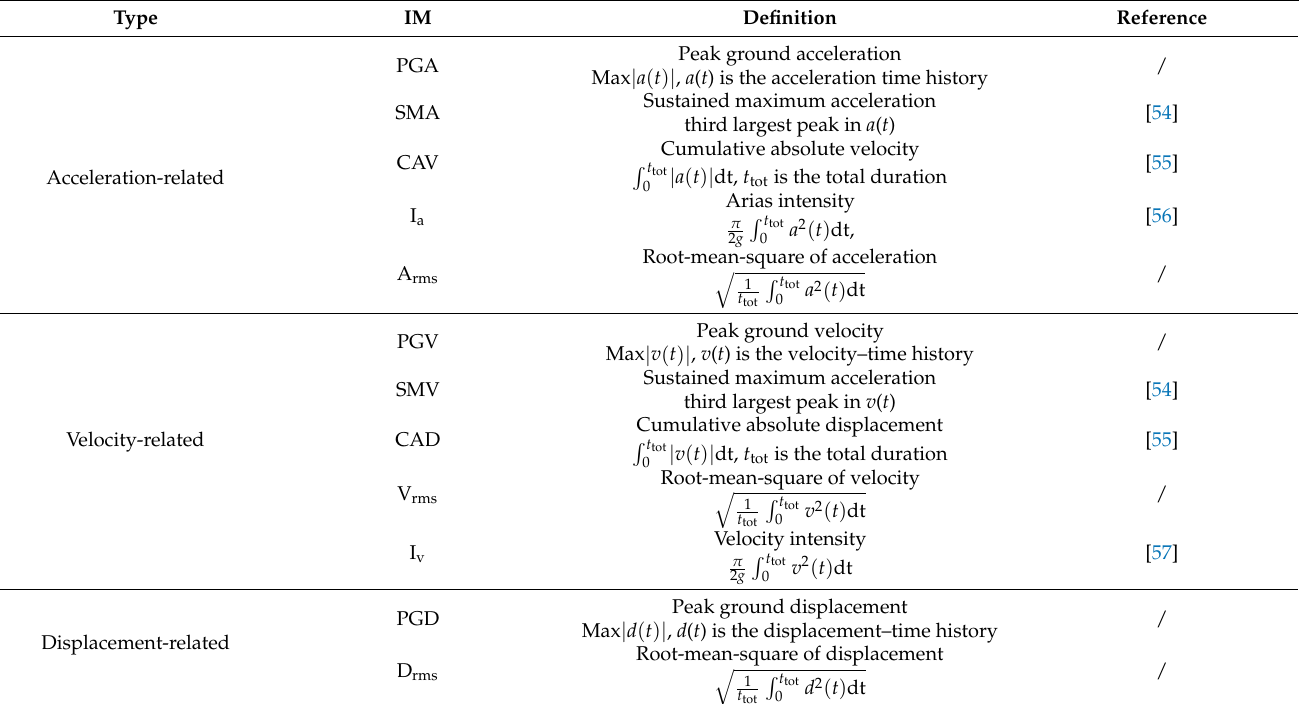
Table 4. Description of the considered Figure 7. Input ground motions for cable-stayed bridges crossing faults.